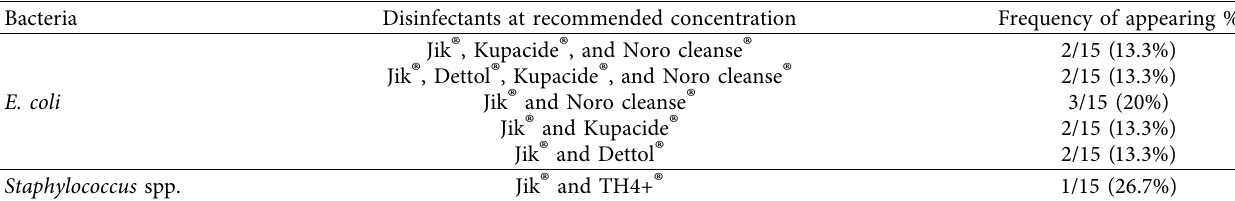
Figure 2: Photograph showing agar diffusion disinfectant susceptibility results. Inhibition zones are pointed by blue arrow (E); wells which were containing the disinfectant are pointed by the red arrow (H). Purple arrow (F) is showing confluent bacterial (of Staphylococcus isolate) growth, and yellow arrow (G) is showing resistance (no inhibition Table 3: Multiple resistance to disinfectants at recommended user concentration.